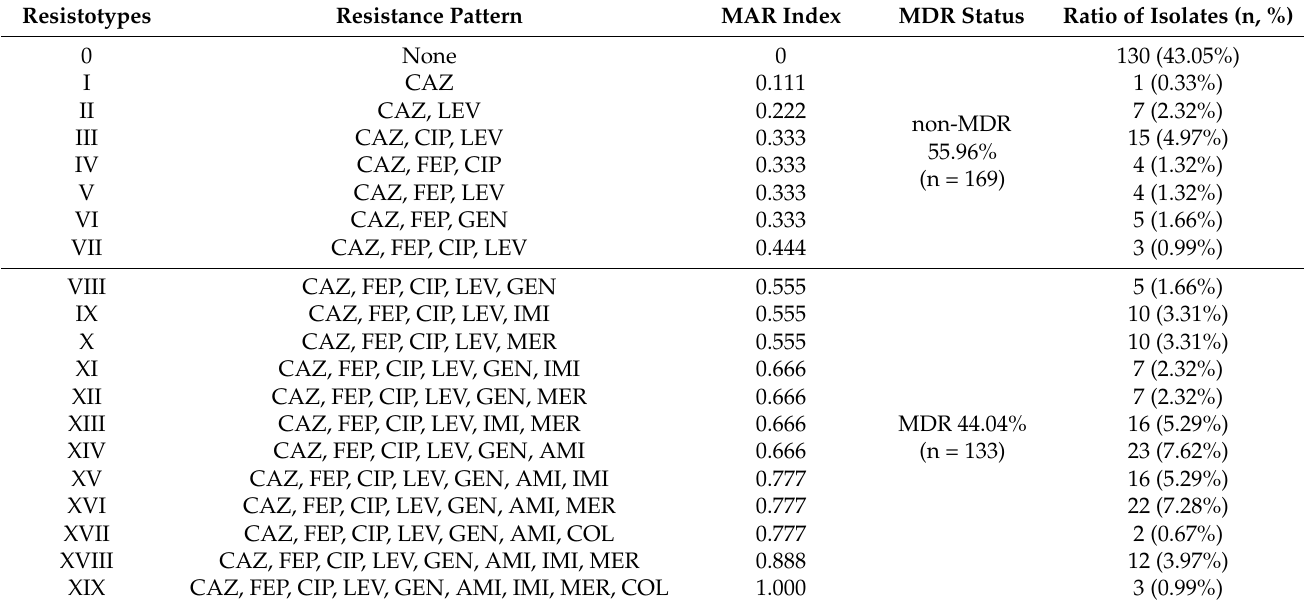
Table 1. Resistotype distribution and MAR indices of respective